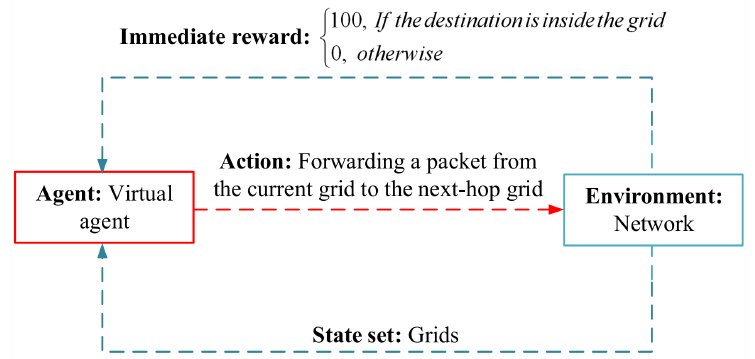
Figure 13. Learning structure in QGrid.